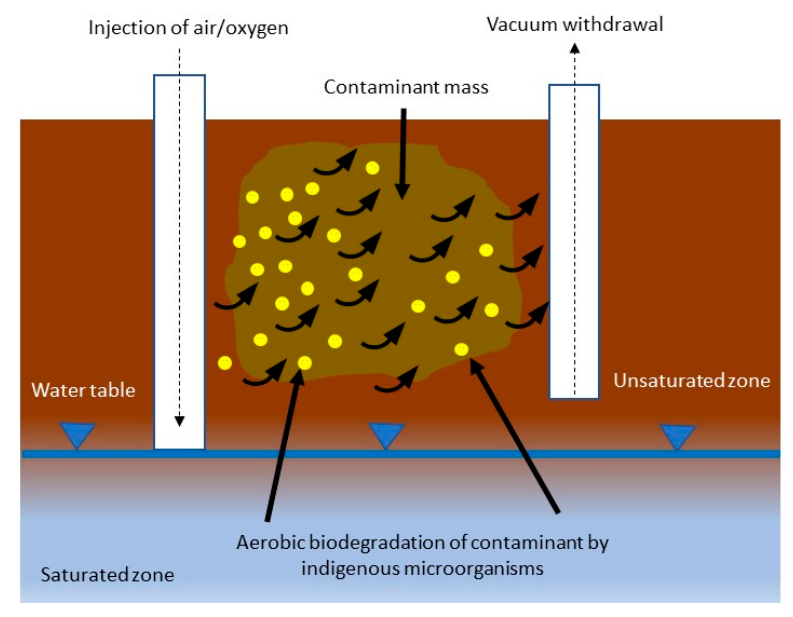
Figure 5. Typical bioventing system (adapted from [59]).